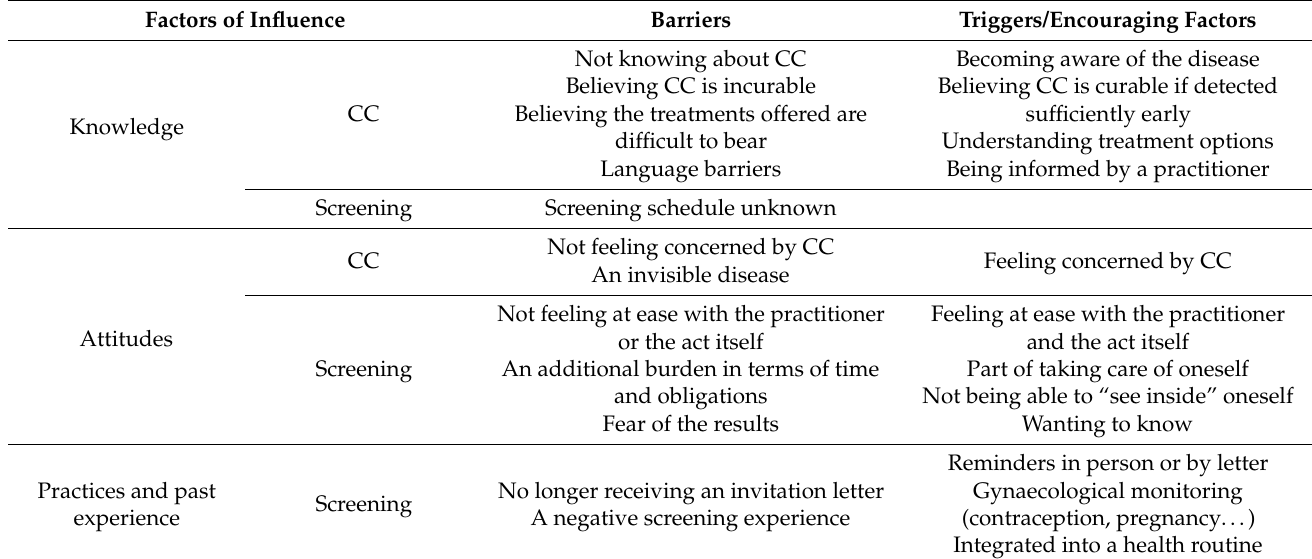
Table 3. Summary of Key Barriers and Triggers to Adopting Recommended Screening